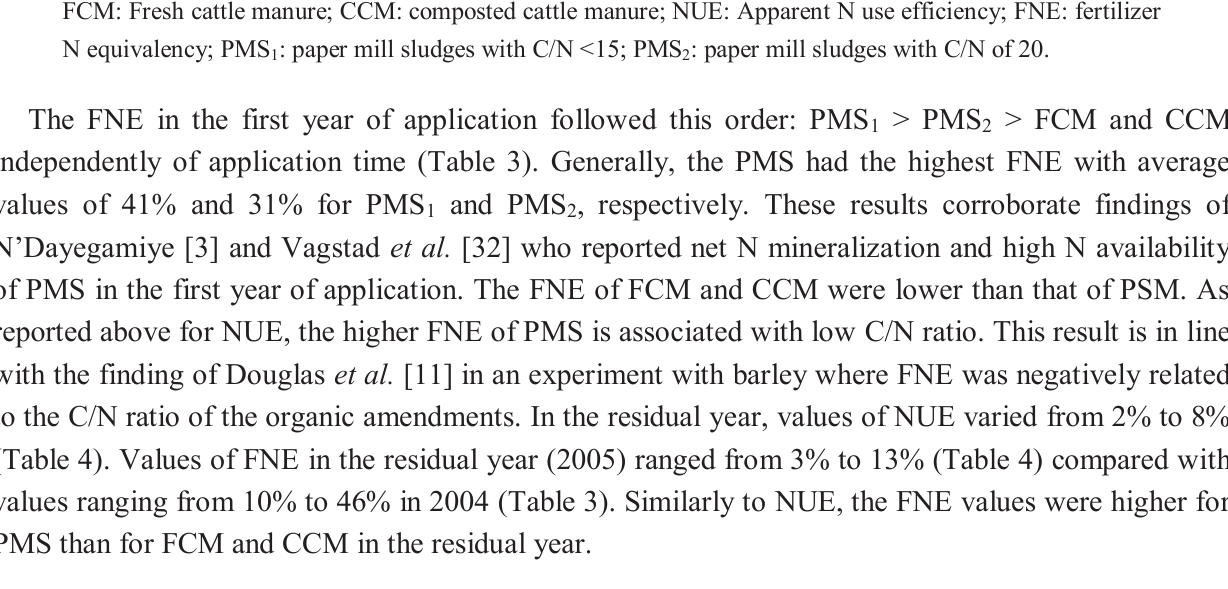
Table 4. Potato N use efficiency and fertilizer N equivalency in the residual year of organic amendments application